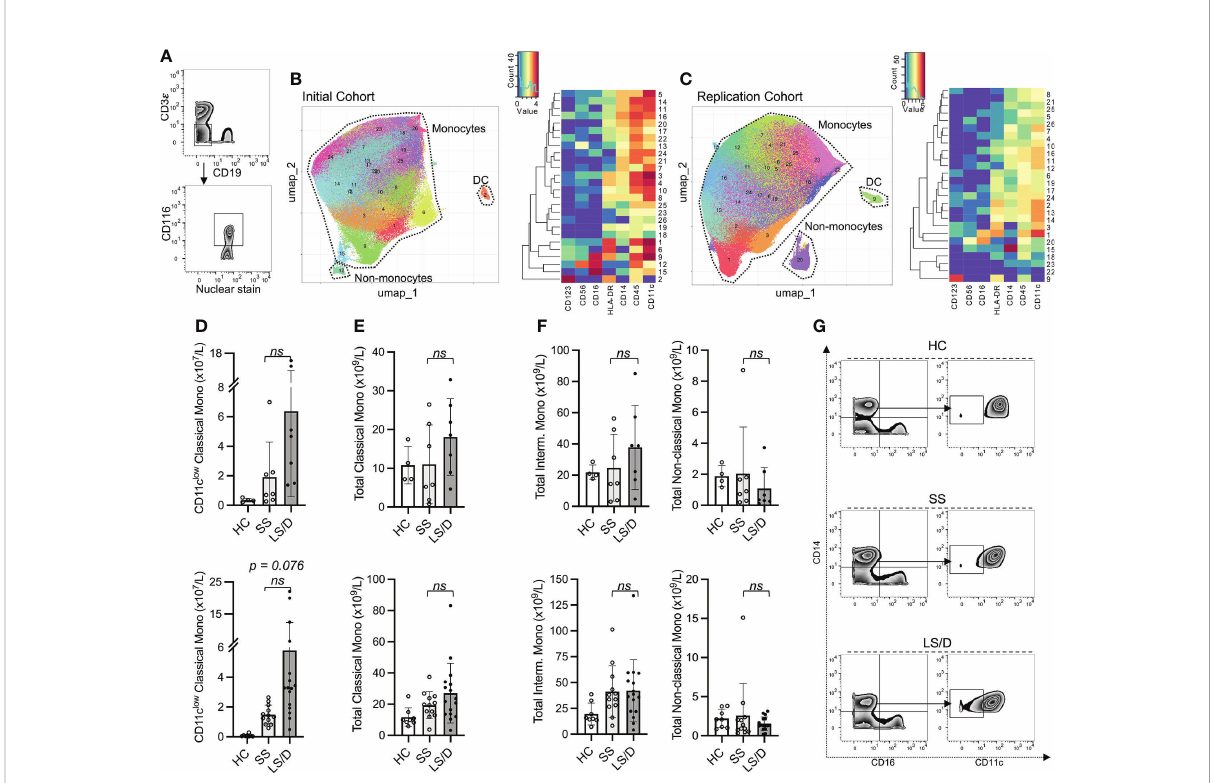
FIGURE 3 CD11c low Classical Monocytes are predictive of clinical outcome. Representative gating of CD116 + CD3 - CD19 - cells (A) . Initial Cohort UMAP projections of CD116+ CD3 - CD19 - gated cells (all samples combined; limited clustering channels) and mean marker expression heatmap of UMAP projections (B) . Same as in B but for the Replication Cohort (C) . Initial (top) and Replication Cohorts (bottom) absolute counts of monocyte subset predictive of clinical outcome (D) . Absolute counts of non-signi fi cant monocyte subset identi fi ed based on gated clustering (top row: Initial Cohort, bottom row: Replication Cohort) (E, F) . Manual gating strategy to view predictive monocyte subset (G) . ns, p ≥ 0.05 by two-tailed, two-sample unequal variance Student ’ s t-test [with Bonferroni adjustment for multiple comparisons in (D)